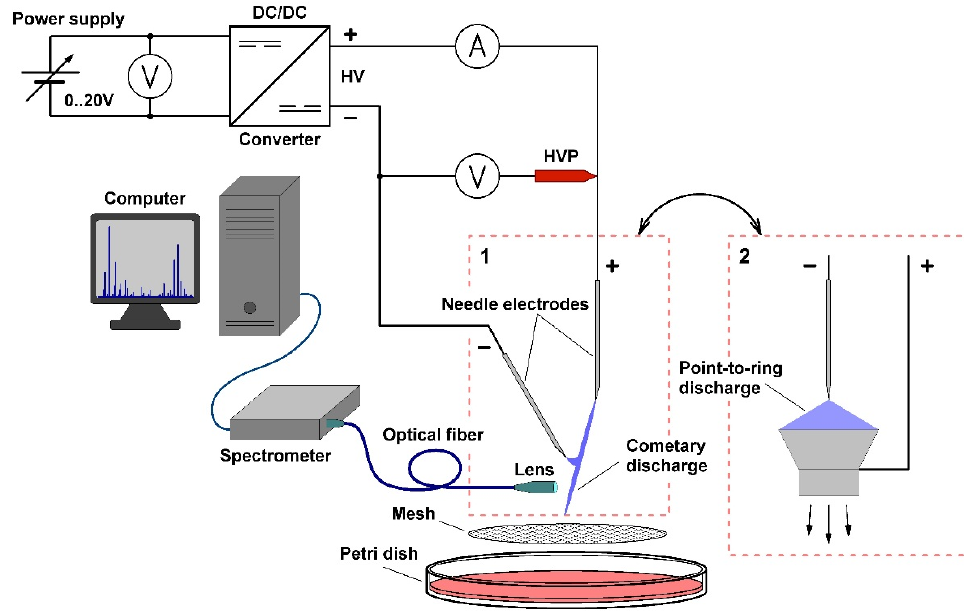
Figure 7. Experimental setup: 1—point-to-point electrode configuration for the cometary discharge, 2—point-to-ring electrode configuration for the corona discharge.